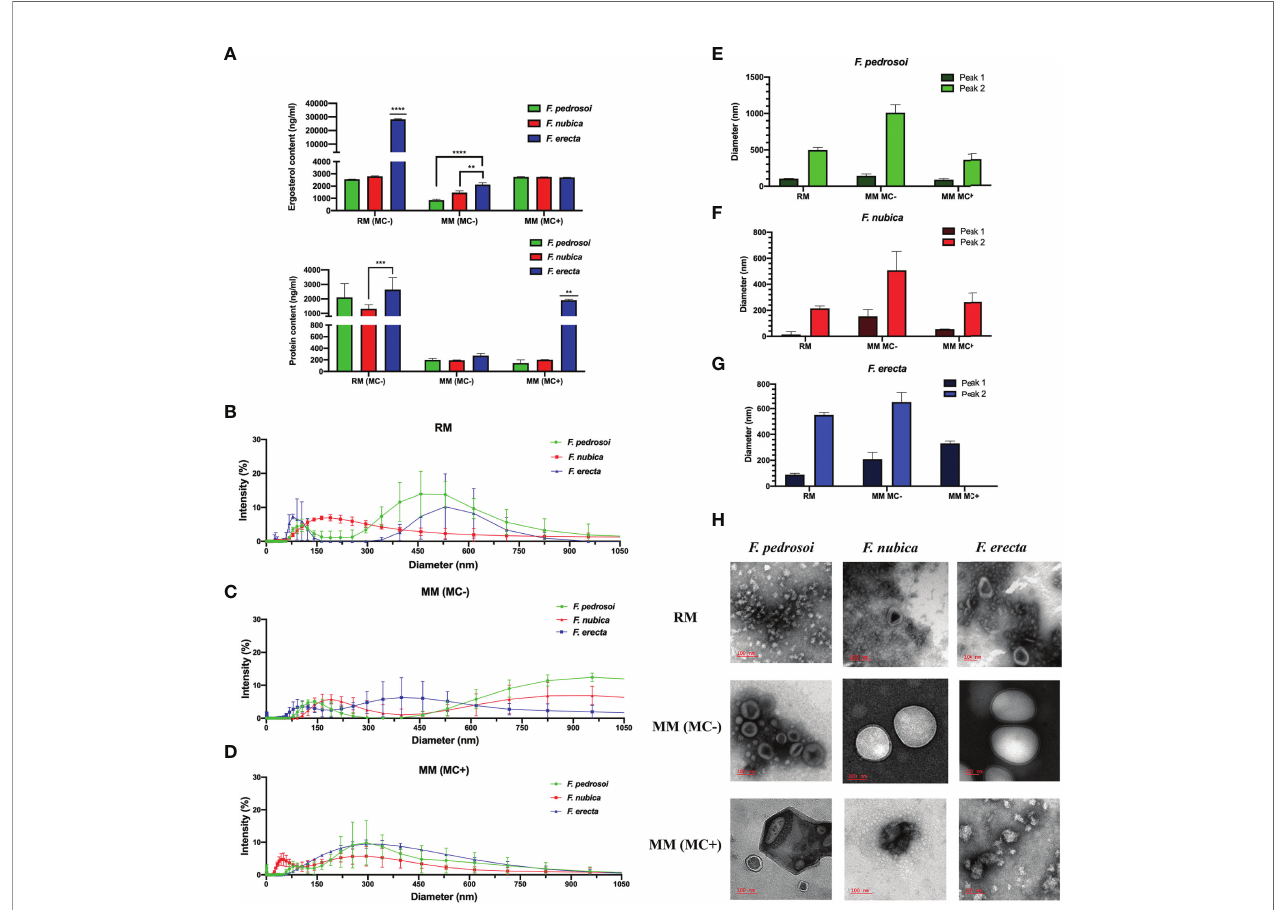
FIGURE 2 | F. pedrosoi , F. nubica , and F. erecta can produce extracellular vesicles (EVs), which are affected by growth conditions. EVs were isolated from F. pedrosoi (green), F. nubica (red), and F. erecta (blue). Ergosterol and protein content (A) of the EVs were measured by Amplex Red Cholesterol assay kit and Micro BCA Protein kit assay, respectively. Dimensional analyses by Dynamic Light Scattering (DLS) of EVs isolated from rich medium (B) , minimum medium without muriform cells (MCs) (C) , and minimum medium with MCs (D) . Average diameter peaks by DLS plotted for F. pedrosoi (E) , F. nubica (F) , and F. erecta (G) . Transmission Electron Microscopy (TEM) imaging was used to assess the EVs ’ morphology and distribution in all conditions (H) . Scale bars: 100nm. For all plots, ** indicates p < 0.01, *** indicates p < 0.001, **** indicates p < 0.0001 according to one-way analysis of variance (ANOVA). The results presented in this work refer to a representative triplicate group experiment of at least two independent